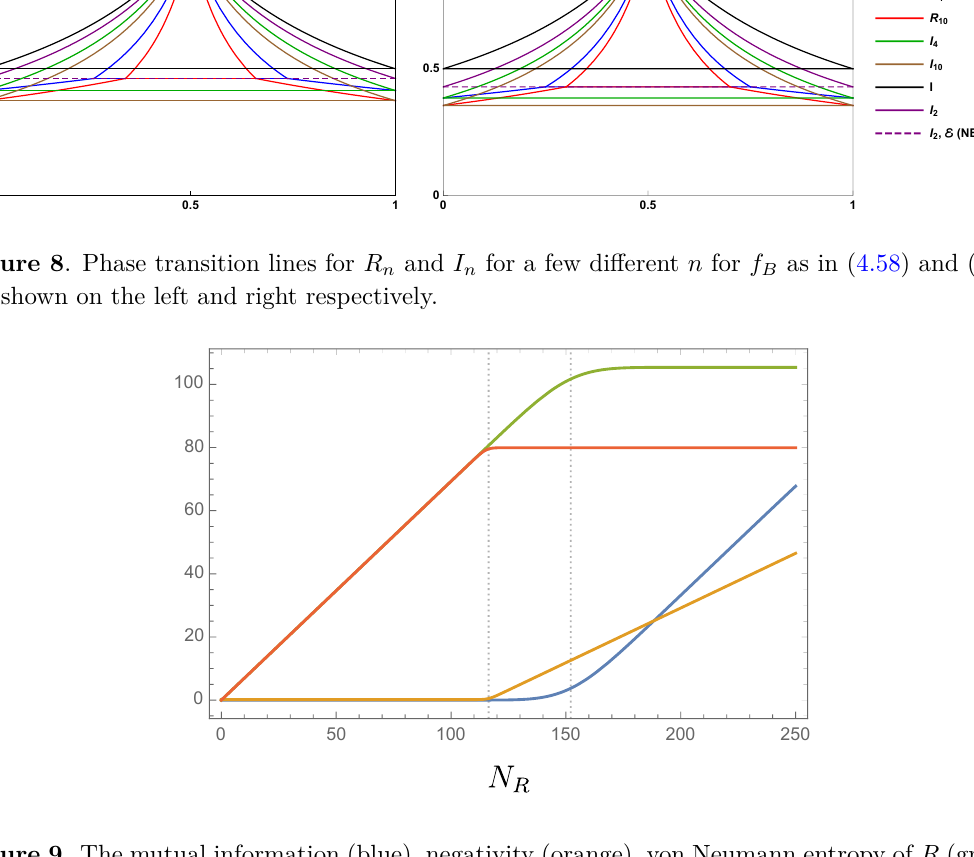
Figure 9 . The mutual information (blue), negativity (orange), von Neumann entropy of R (green), and second Rényi entropy of R (red) are shown when B is in the canonical ensemble and A at infinite temperature. While the mutual information within A becomes volume-law when the von Neumann entropy of A saturates, the negativity becomes volume-law when the second Rényi entropy saturates, a significantly earlier time. We also note that the finite temperature corrections around the transition point are significantly larger for the mutual information than they are for negativity, which has a sharper transition. We take V = 100 and β = 1 / 2 for a Cardy-like density of states B p E for B , ρ ( E ) = e V B VB